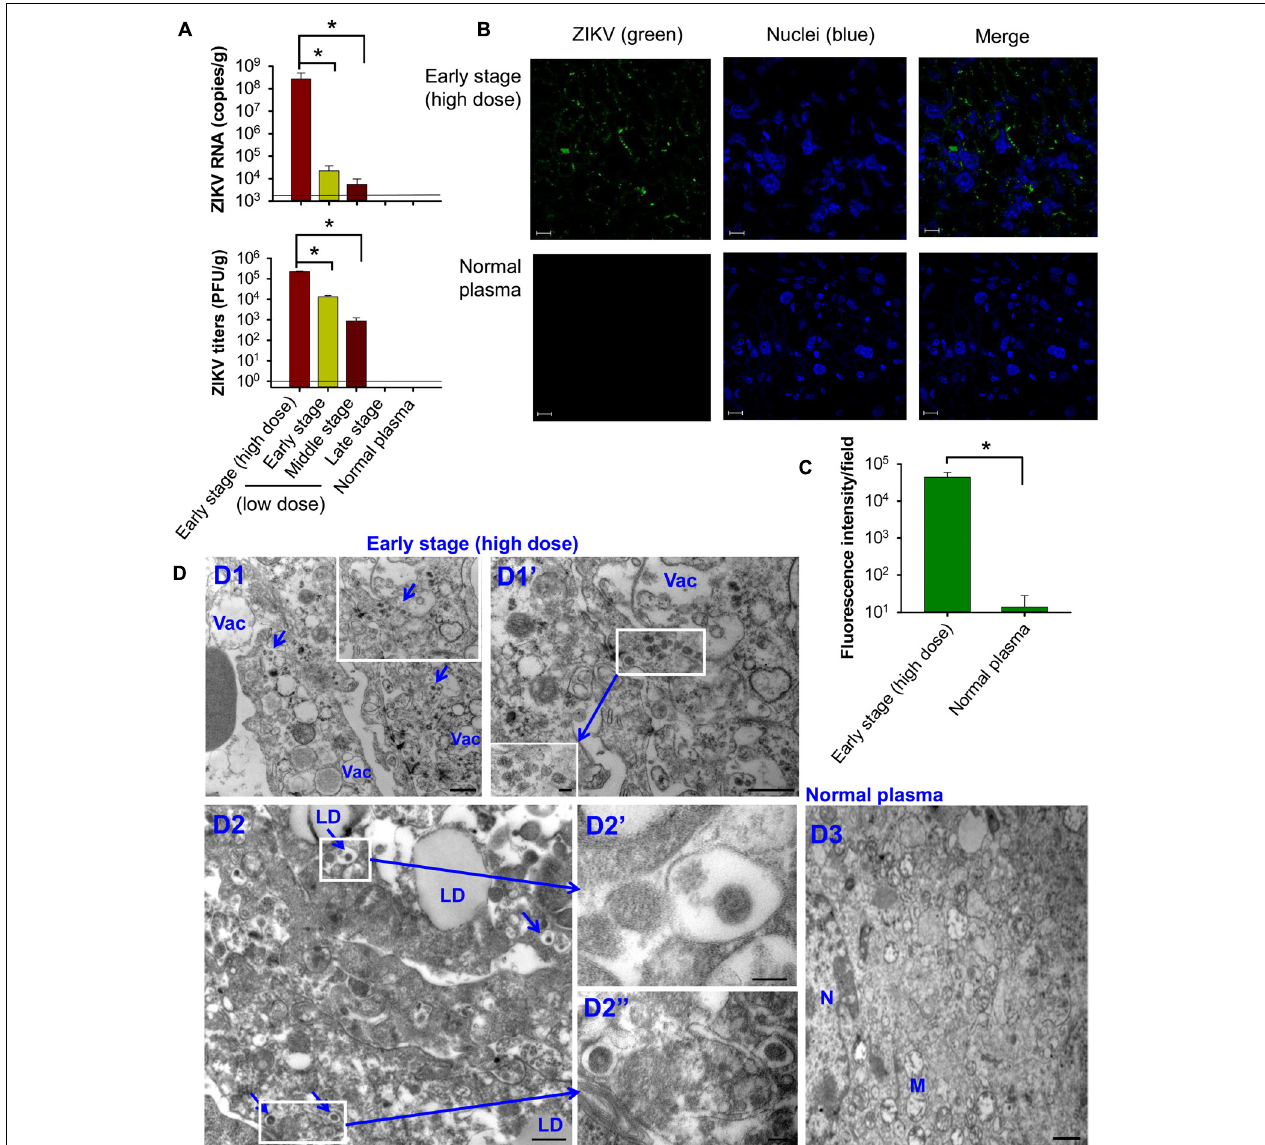
FIGURE 4 | Transfusion of pregnant A129 mice with early-stage (high dose) ZIKV + plasma led to significant placental infection. Pregnant (E10–12) A129 mice were transfused with ZIKV + plasma from early, middle, and late stages, respectively, and placentas were collected 6 days after transfusion for below tests. Detection of ZIKV RNA by qRT-PCR ( A , top) and ZIKV titers by plaque assay ( A , bottom). The data are presented as means ± s.e.m ( n = 6 mice/group). ∗ indicates significant differences between early stage (high dose) and early or middle stages (low dose). The detection limit, shown as the horizontal lines, for qRT-PCR and plaque assay was about 2.5 × 10 3 RNA copies/g and 1 PFU/g, respectively. (B) Immunofluorescence staining of placental tissues of pregnant mice transfused with early-stage (high dose) ZIKV + plasma. ZIKV (green) was stained using ZIKV EDIII-specific mAb ZV-64. Nuclei were stained with DAPI, and are shown in blue. Representative images are listed. Magnification: 63X; Scale bar: 10 µ m. (C) Quantification of ZIKV staining in (B) was calculated by ImageJ software for the relative intensity (particle analysis) of ZIKV staining with fluorescent signals. The data are presented as mean fluorescence intensity (e.g., ZIKV + staining) in each field ± s.e.m ( n = 6, “ n ” indicates numbers of image from different placentas). ∗ indicates significant differences between early stage (high dose) and normal plasma groups. (D) TEM analysis of placental tissues collected from the mice transfused with early-stage (high dose) ZIKV + plasma. D1–D2, microphotographs show ZIKV particles in the placentas of ZIKV + plasma-transfused mice. Infected cells were highly vacuolated and abundant with lipid droplets. Short arrows indicate ZIKV particles. D3, placental tissues collected from normal plasma-transfused mice. Vac, vacuole; LD, lipid droplet; M, mitochondria; N, nuclei. Scale bar: 500 nm for D1, D1”, D2, and D3, and 100 nm for D1’ insertion, D2’, and D2”. Normal plasma: control plasma from A129 mice transfused with normal plasma without ZIKV.